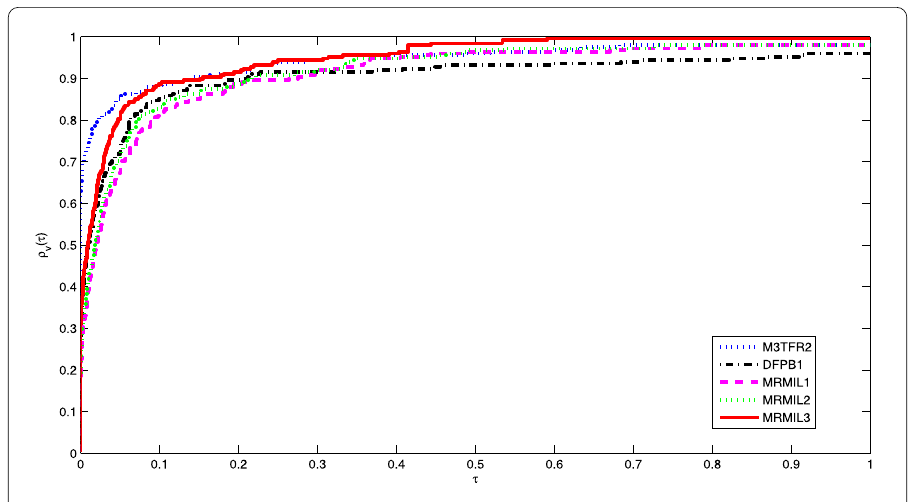
Figure 2 Performance profiles for the number of function evaluations in a log 2 scale